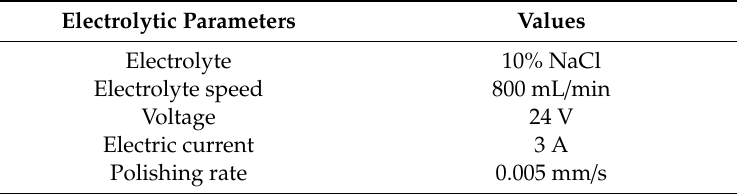
Figure 8. ( a ) The details of X-ray residual stress measurement; ( b ) The electrolytic corrosion device. Table 4. The electrolytic